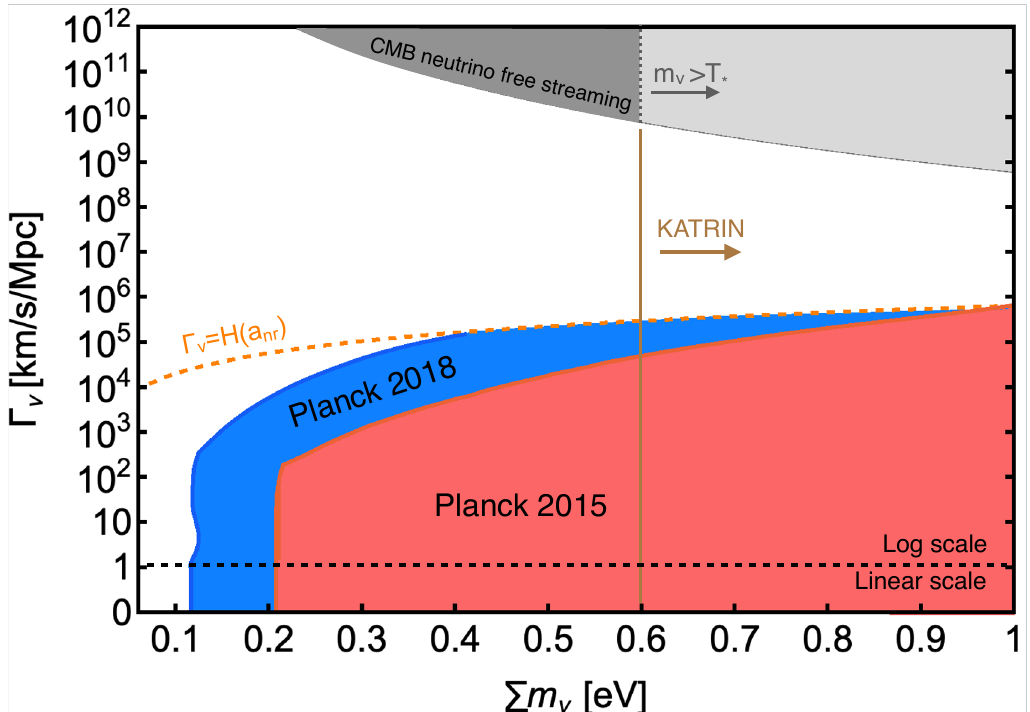
Figure 1 . The plot shows the current constraints on decaying neutrinos in the P m ν − Γ ν parameter space. The colored regions are excluded by current data while the white region is allowed. The orange dashed line represents Γ = H ( a ) . Our study focuses on the region below this line, meaning decay ν nr happens after neutrinos have become non-relativistic. The grey region shows current constraints on neutrino mass and lifetime coming from the requirement that neutrinos are free streaming close to recombination [13]. The light grey region indicates that this bound may not be applicable when neutrino mass is larger than the temperature of recombination: m 0 . 2 eV [13]. Our ν > T ∗ ∼ analysis excludes the red (blue) region labelled “Planck 2015”(“Planck 2018”) based on the data (Planck+BAO+Pantheon). The vertical brown line shows the projected KATRIN